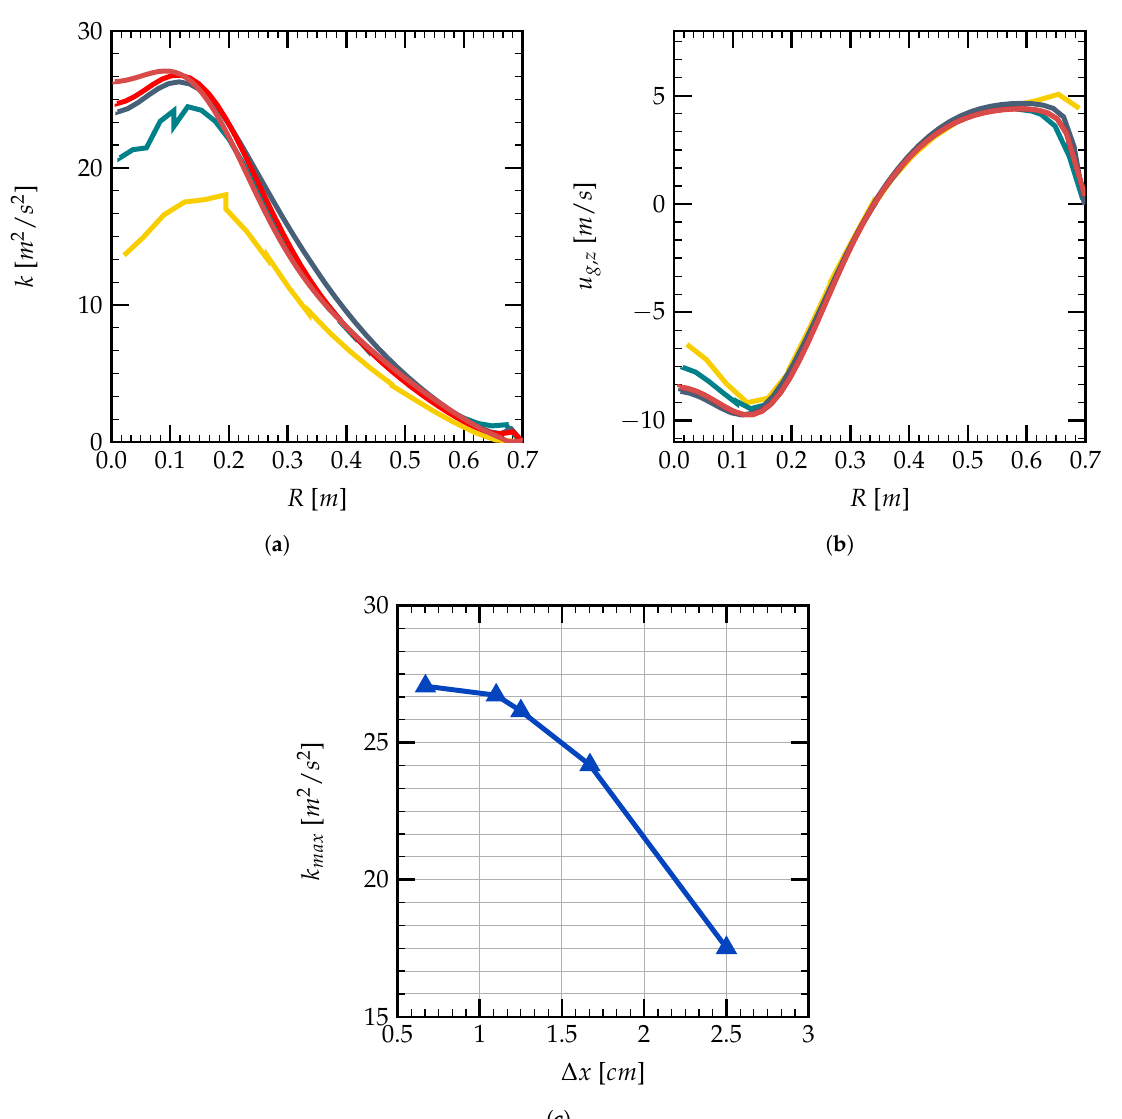
Figure 4. Mesh convergence of different flow parameters as a function of the radial distance from the center R at plane h = 60 cm; results of the mean mesh size ∆ x = 2.5 cm ( ), ∆ x = 1.67 cm ( ), ∆ x = 1.25 cm ( ), ∆ x = 1.11 cm ( ), and ∆ x = 0.67 cm ( ); ( a ) turbulence kinetic energy k , ( b ) axial gas velocity u g , z , and ( c ) the mesh convergence tendency for k max as a function of mean mesh size ∆ x at plane h = 60 cm (